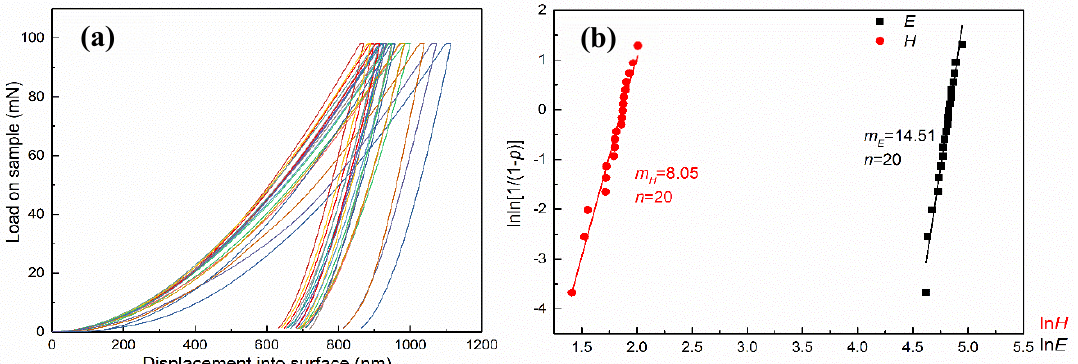
Figure 3. Load-displacement curves ( a ) and Weibull distribution plots of E and H ( b ) of NiCoCrAlYCe coatings.